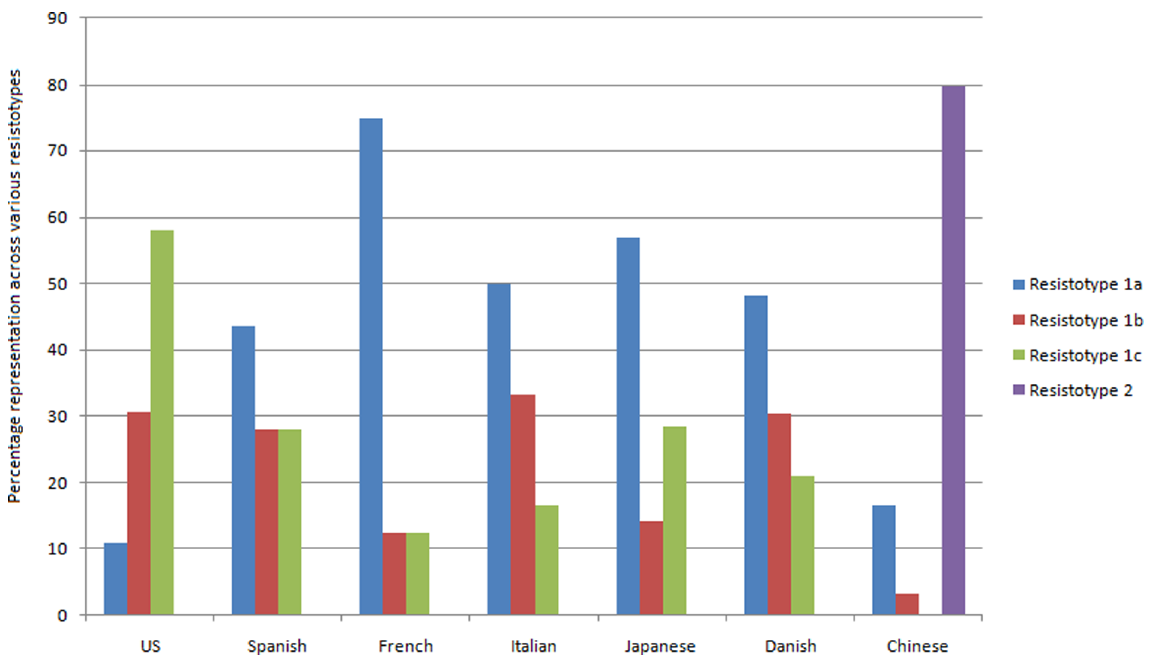
Figure 8. Percentage representation of gut microbiomes belonging to various nationalities within the four resistotypes.